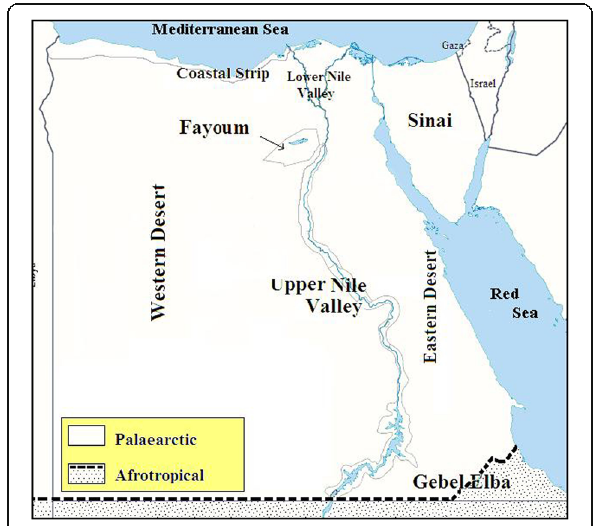
Fig. 1 Map of Egypt showing the ecological zones (taken from El- Hawagry and Gilbert